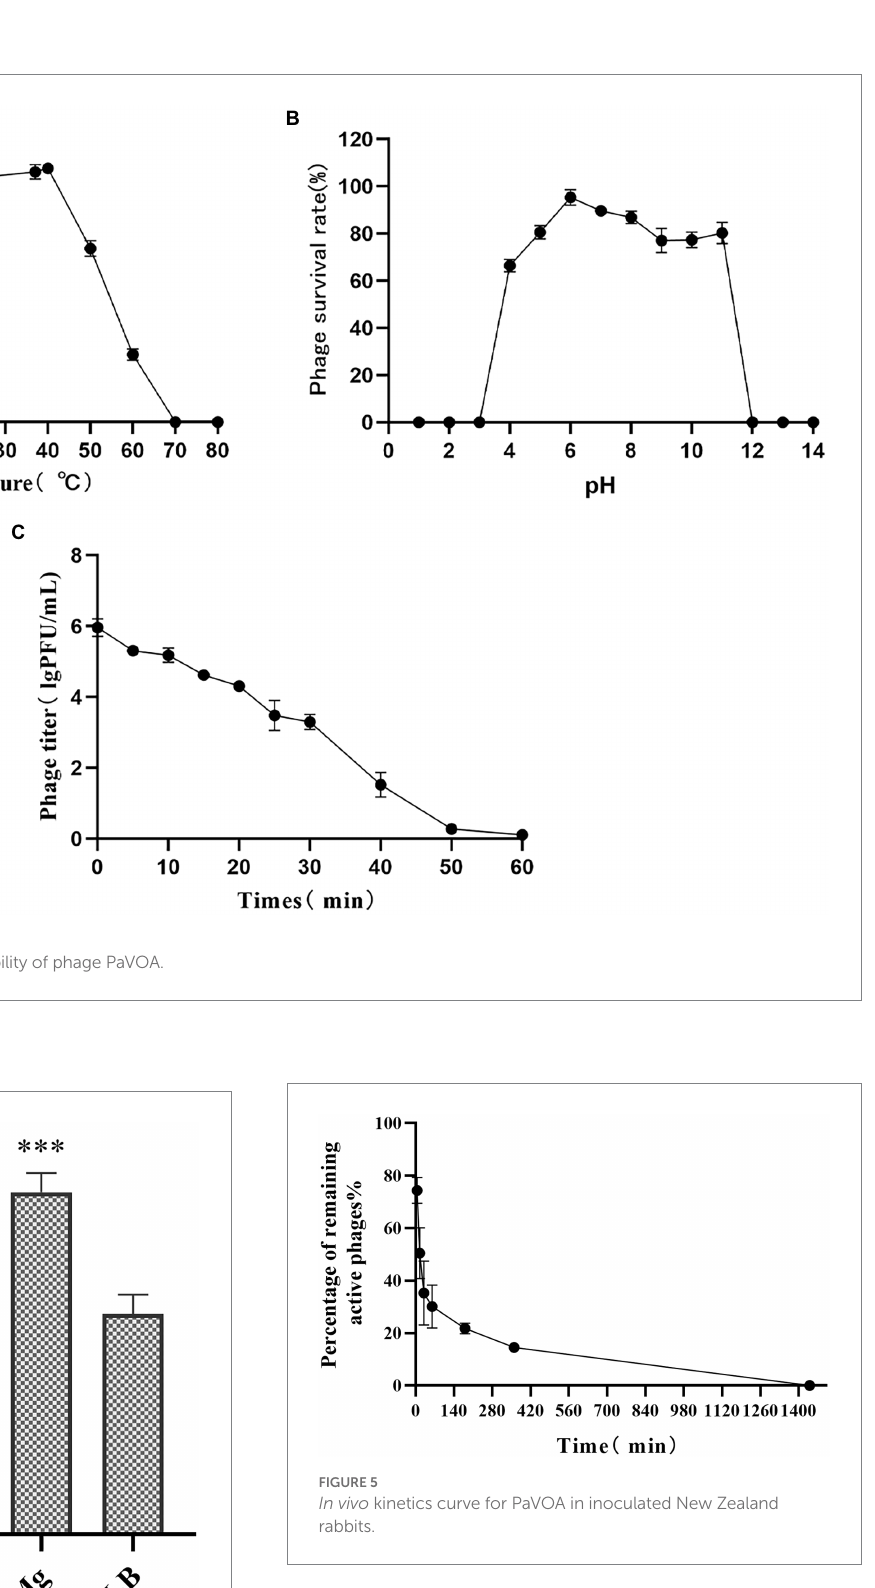
Photo documentary and wound healing analyses The wound healing of the treatment and control groups on days 0, 3, 7, 12, 17, and 22 are shown in Figure 6A. Wound healing percentage results (Figure 6B) showed that the wounds in each group had different degrees of expansion on day 3. From